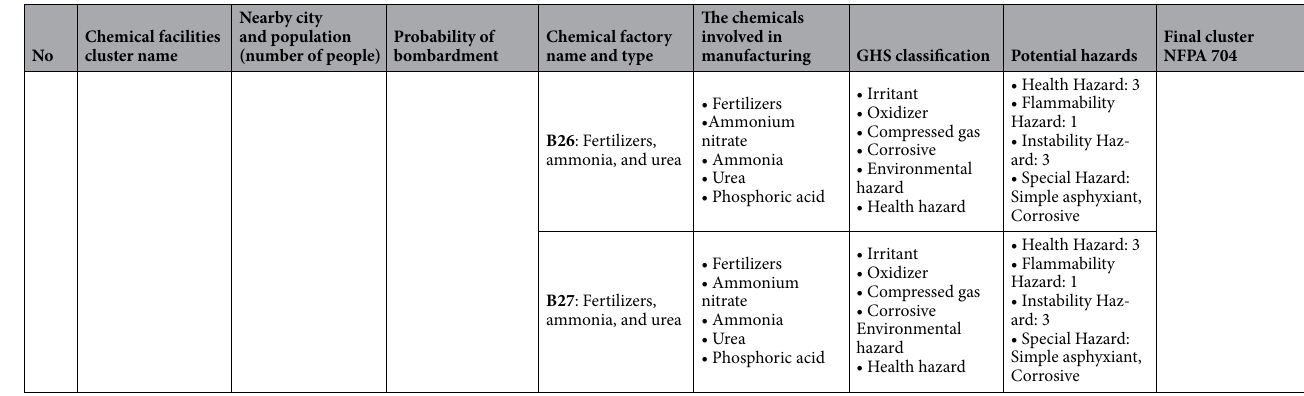
Table 4. Cluster analysis table for Luhansk